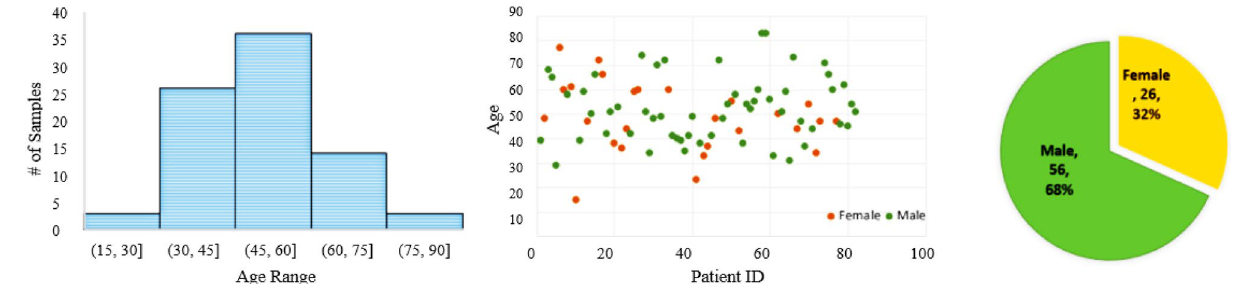
Figure 3. Age and gender distribution of the COVID-CT-Rate dataset.